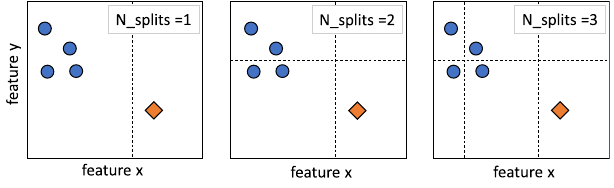
FIG. 1. A conceptual illustration of the IF algorithm. An anomalous point is more likely to be isolated by just one random split on a randomly selected input feature, compared to three splits required to isolate each of the core data points.